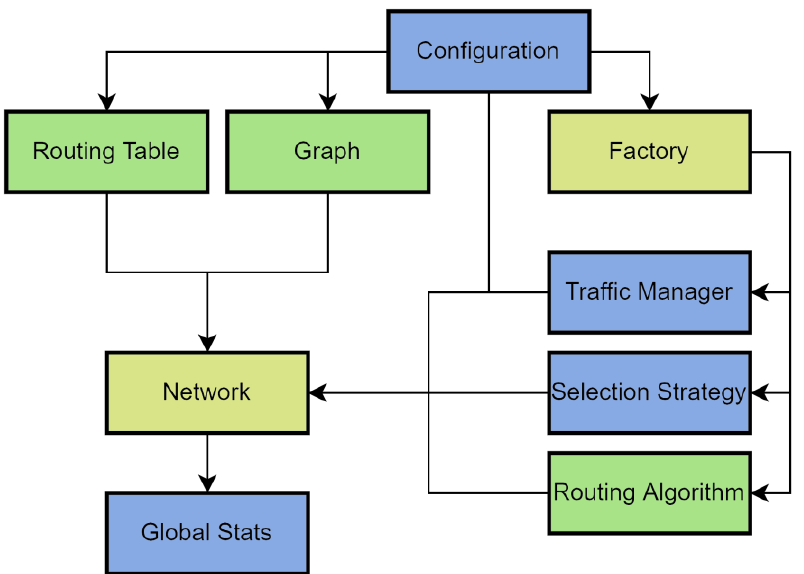
Figure 2. Structure of the Newxim simulator. The configurator takes the input parameters (that describe the future modeling pro- cess), checks the validity of the values, and builds the network structure. The description of the network structure is passed to the simulator core, which creates the network itself and starts the simulation. Next, the metrics of the simulation cycles performed are calculated and based on the obtained values, and the final report is